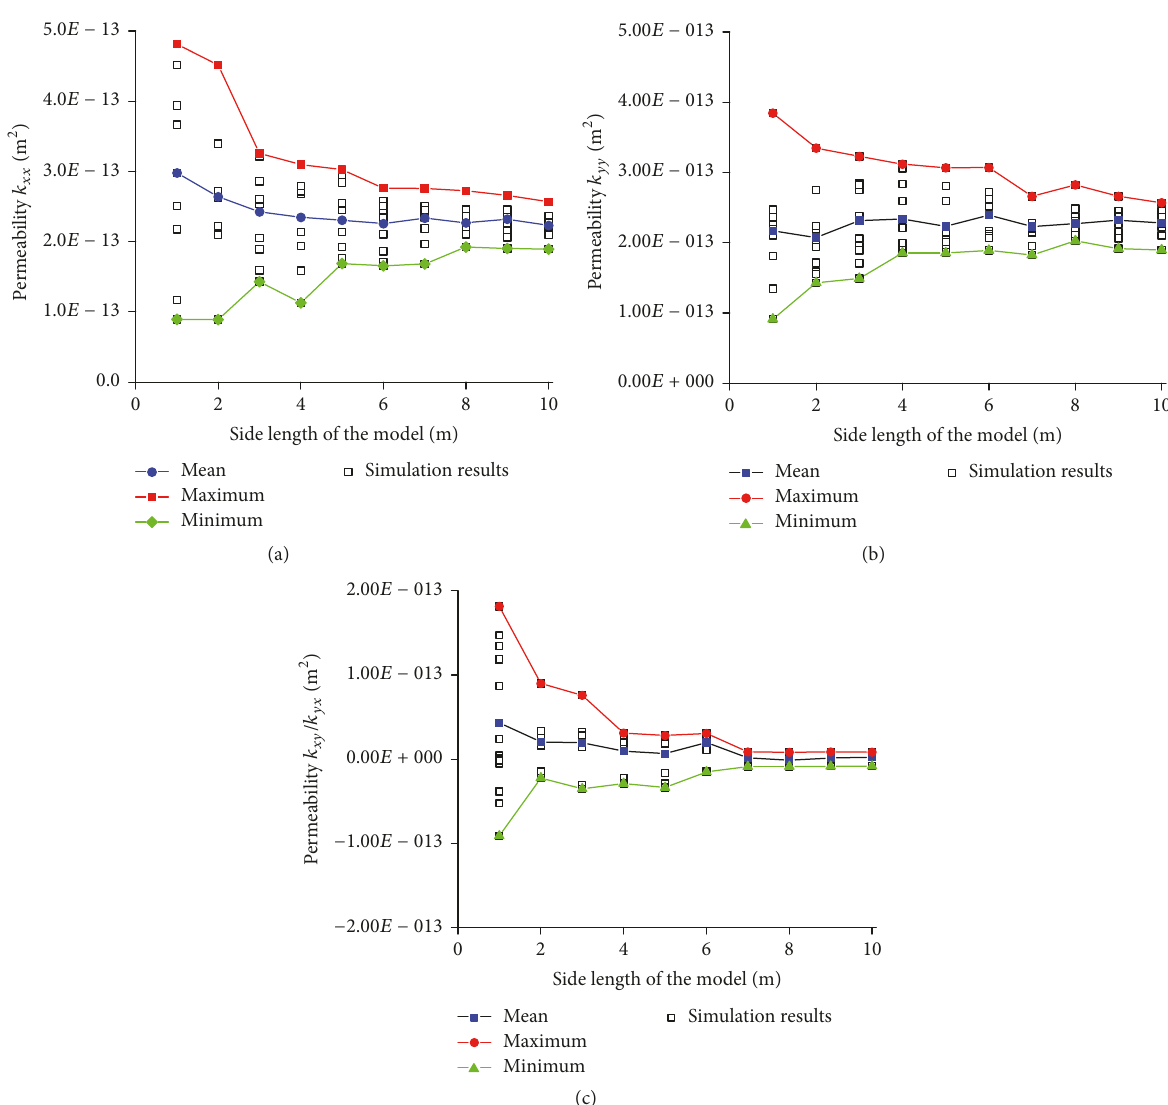
Figure21:Theresults,Max,Min,andmeanofcalculatedintrinsicpermeabilitycomponentsintheDarcyflow.(a) 𝑘 𝑥𝑥 ,(b) 𝑘 𝑦𝑦 ,(c) 𝑘 𝑥𝑦 ,and 𝑘 𝑦𝑥